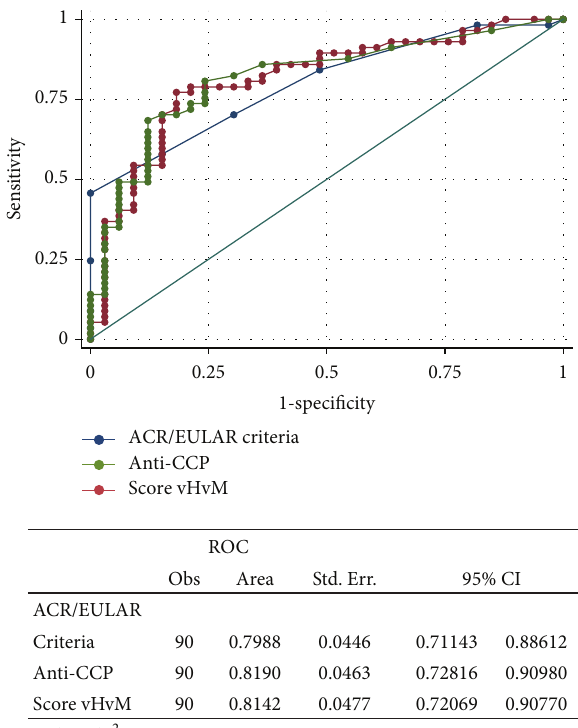
Figure 2: Comparison of receiver operator characteristic (ROC) curve of the new ACR/EULAR criteria, van der Helm-van Mil prediction score, and anti-CCP for prescription of